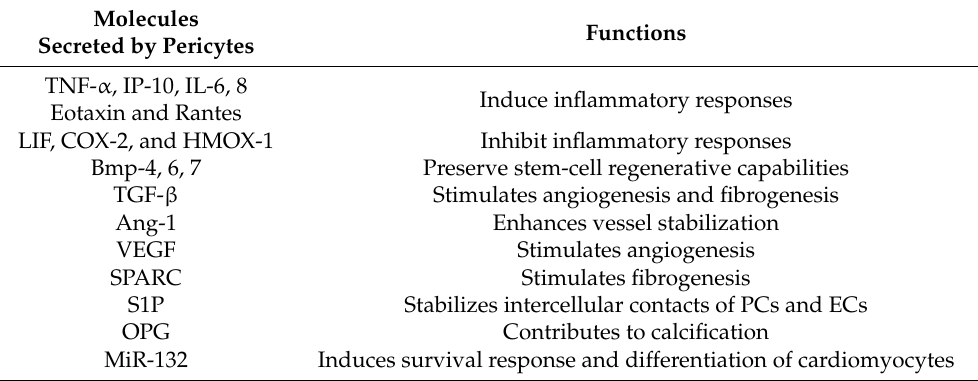
Table 3. Molecules secreted by pericytes and their